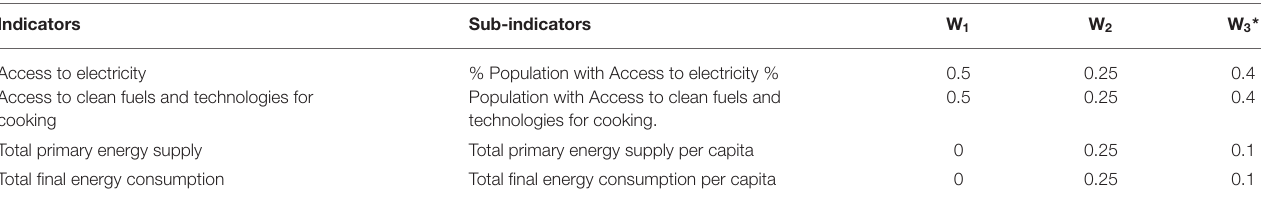
TABLE 2 | Weight sets for WAEPI scenarios.